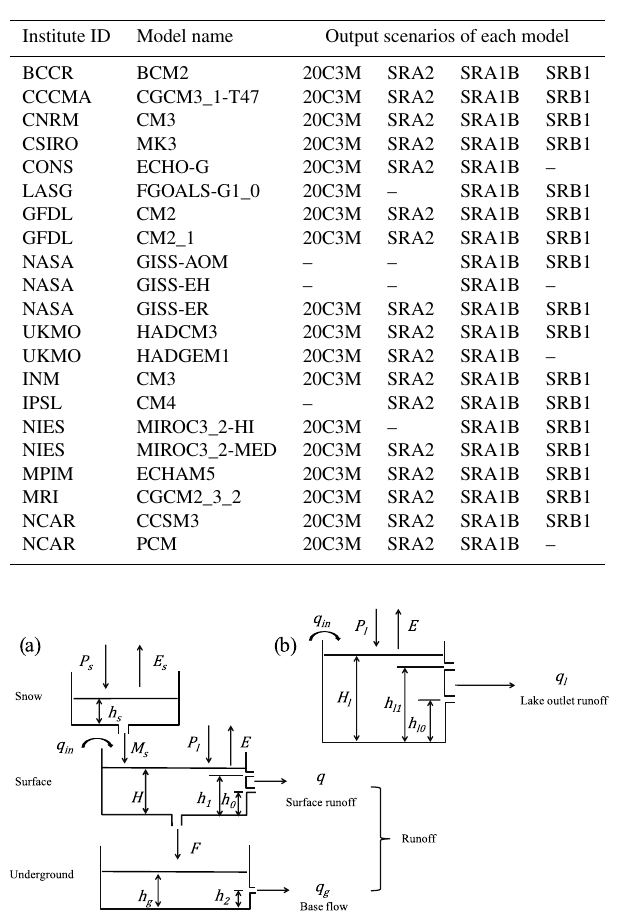
Figure 2. Typical tank model constructions, panels (a) and (b) in- dicate land surface HRU and lake HRU,